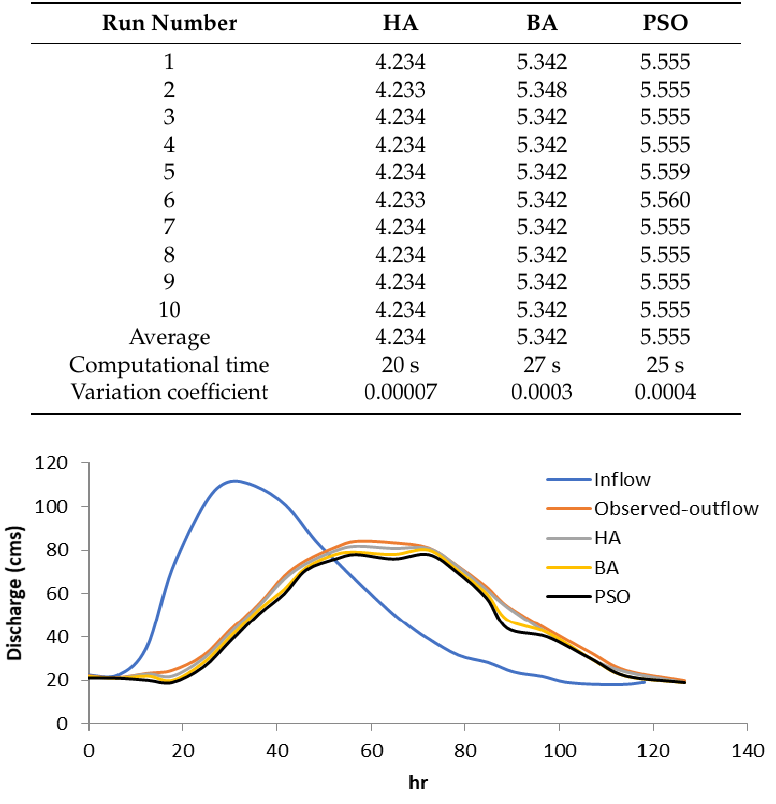
Figure 3. Simulated discharges based on different methods for the Wilson flood.